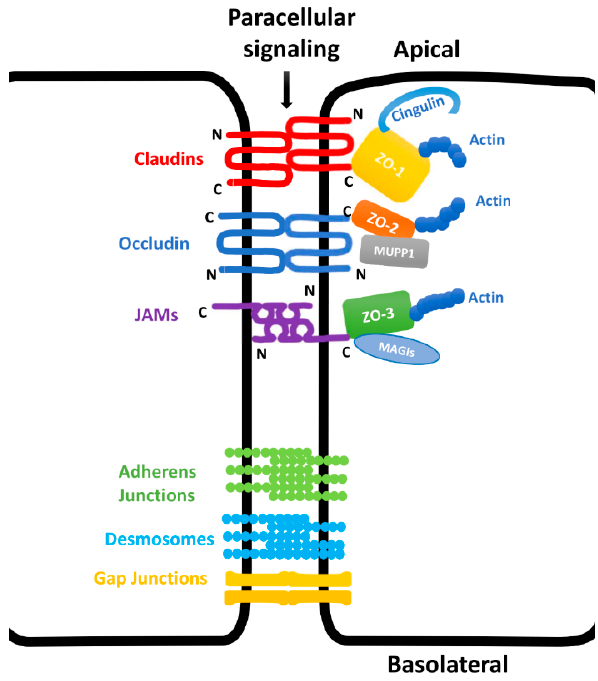
Figure 1. Schematic structures of major bicellular tight junction proteins. The tight junction (TJ) is part of cell-cell junction complex. Major bicellular TJ proteins include three transmembrane protein families: occludin, claudins, and junctional adhesion molecules (JAMs) and a few families of peripheral intracellular membrane proteins such as zonula occludens (ZOs), which connect the transmembrane TJ molecules to the actin filament cytoskeleton.